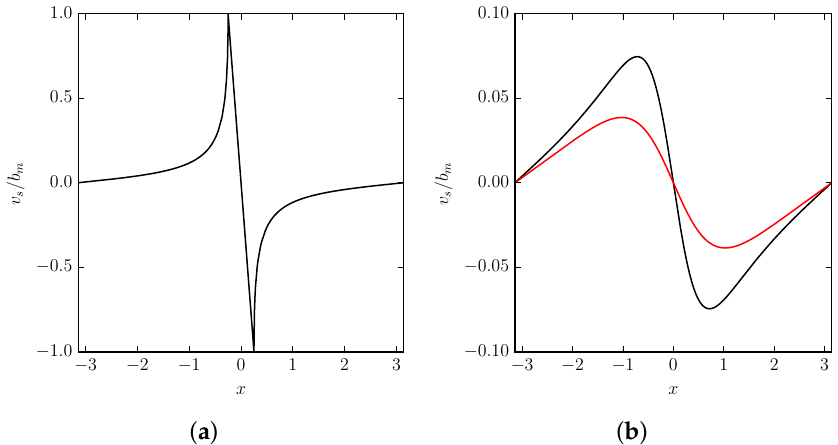
Figure 2. Dimensionless velocity profiles v s ( x , z ) / b m associated with an undisturbed surface buoyancy filament of half-width a = 0.25. ( a ) surface flow at z = 0; ( b ) flows at the depths of the upper vortex ( z 1 = 3 a , black curve) and the lower vortex ( z 2 = −